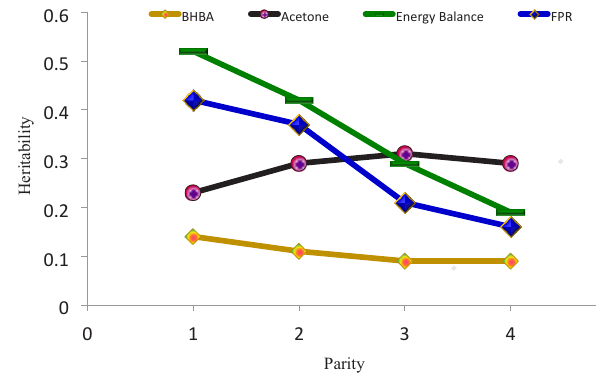
Figure 3. Heritability estimates of milk BHBA, milk Ac, EB, and FPR according to parities from parity 1-4 (FPR, fat to protein ratio; EB, energy balance; Ac, Acetone, BHBA- β -hydroxybutyrate).